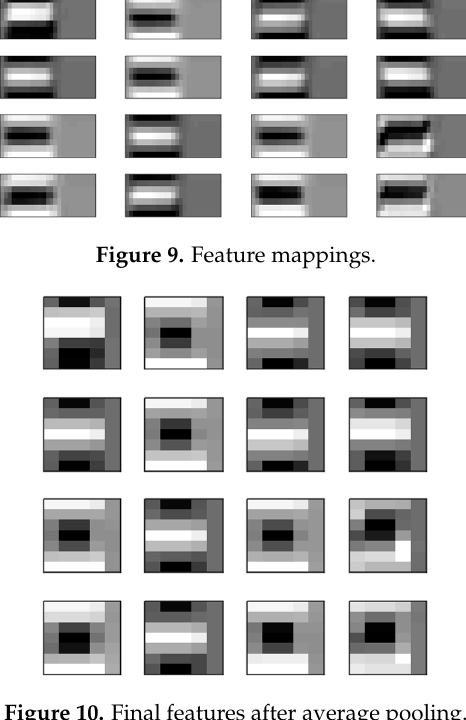
Table 3. Average Classification Label for Various Types of Voltage Sag Sources.